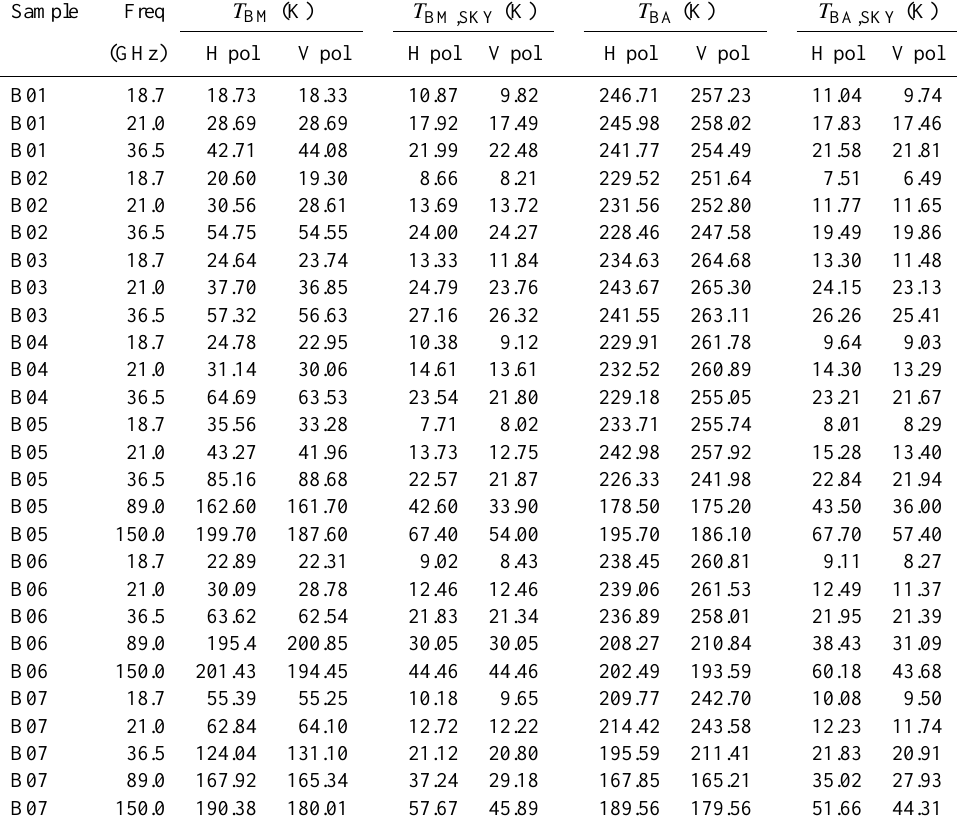
Table 2. Radiometric data measured from the 2015 ASMEx slabs (horizontal/vertical polarization). Brightness temperatures from reflective base ( T BM ), sky after reflective base measurements ( T BM,SKY ), absorbing base ( T BA ), and sky after absorbing base measurements ( T BA,SKY ) are